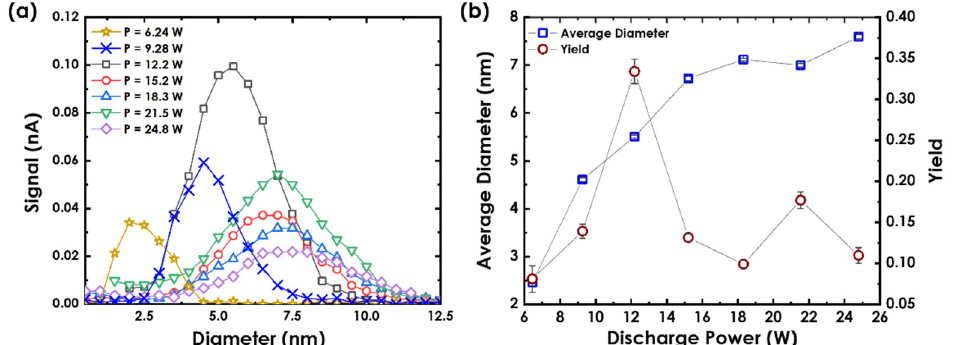
Figure 3. ( a ) Au nanoclusters’ size distributions as measured via the QMF at different P . ( b ) The dependence of Au nanoclusters’ average diameter and yield on P at f = 60 sccm and L = 60 mm.